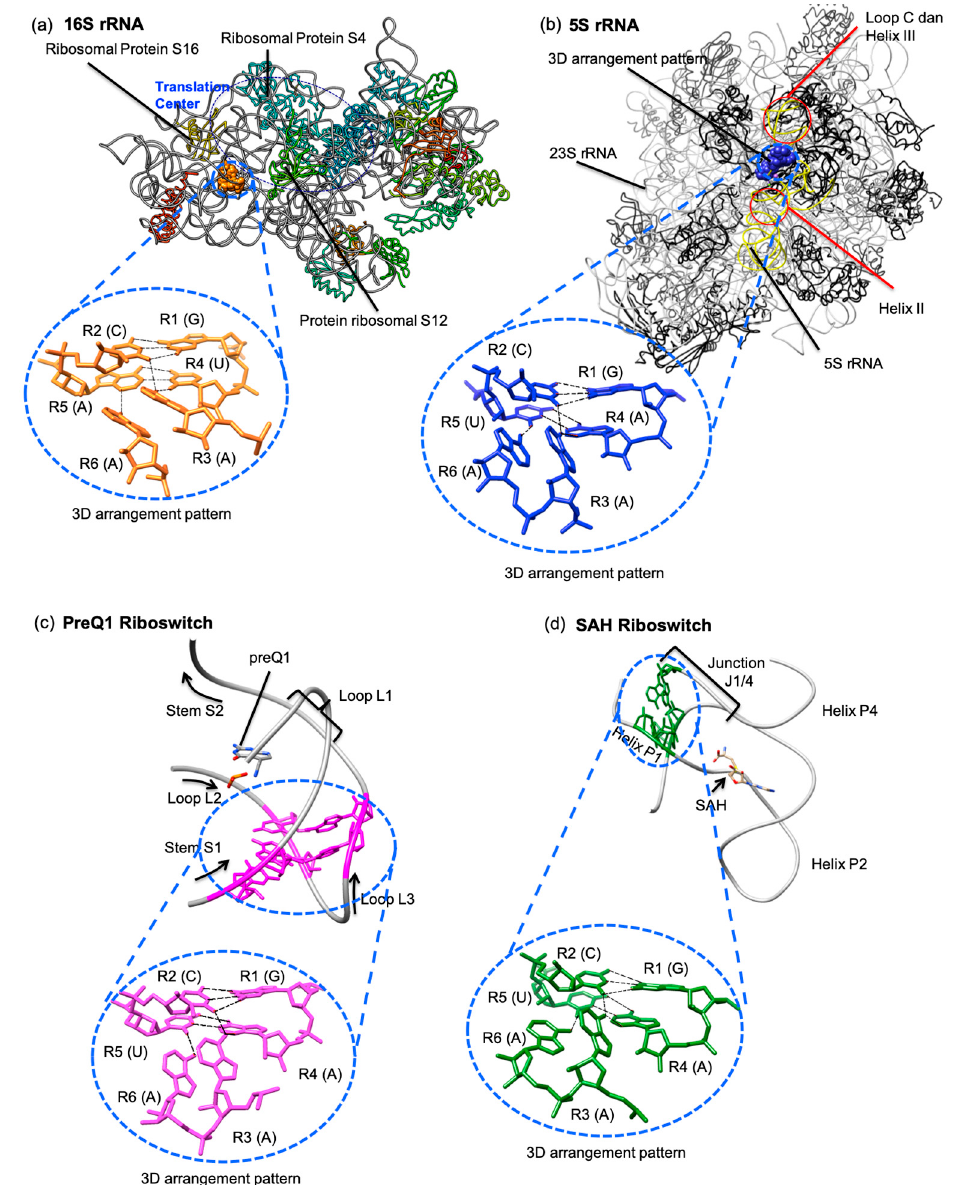
Figure 4. The GCA(A / U)(U / A)A motif ( a ) in the 16S rRNA crystal structure represented as orange spheres and magnified to show the base arrangements using orange stick representations (PDB ID: 1IBM) [27]; ( b ) in the 5S rRNA crystal structure represented as blue spheres and magnified to show the base arrangements using blue stick representations (PDB ID: 1JJ2) [31]; ( c ) in the preQ1 riboswitch crystal structure represented as purple sticks with the arrangement extracted and magnified (PDB ID: 3K1V) [29]; ( d ) in the SAH riboswitch crystal structure represented as green sticks with the arrangement extracted and magnified (PDB ID: 3NPQ) [32].